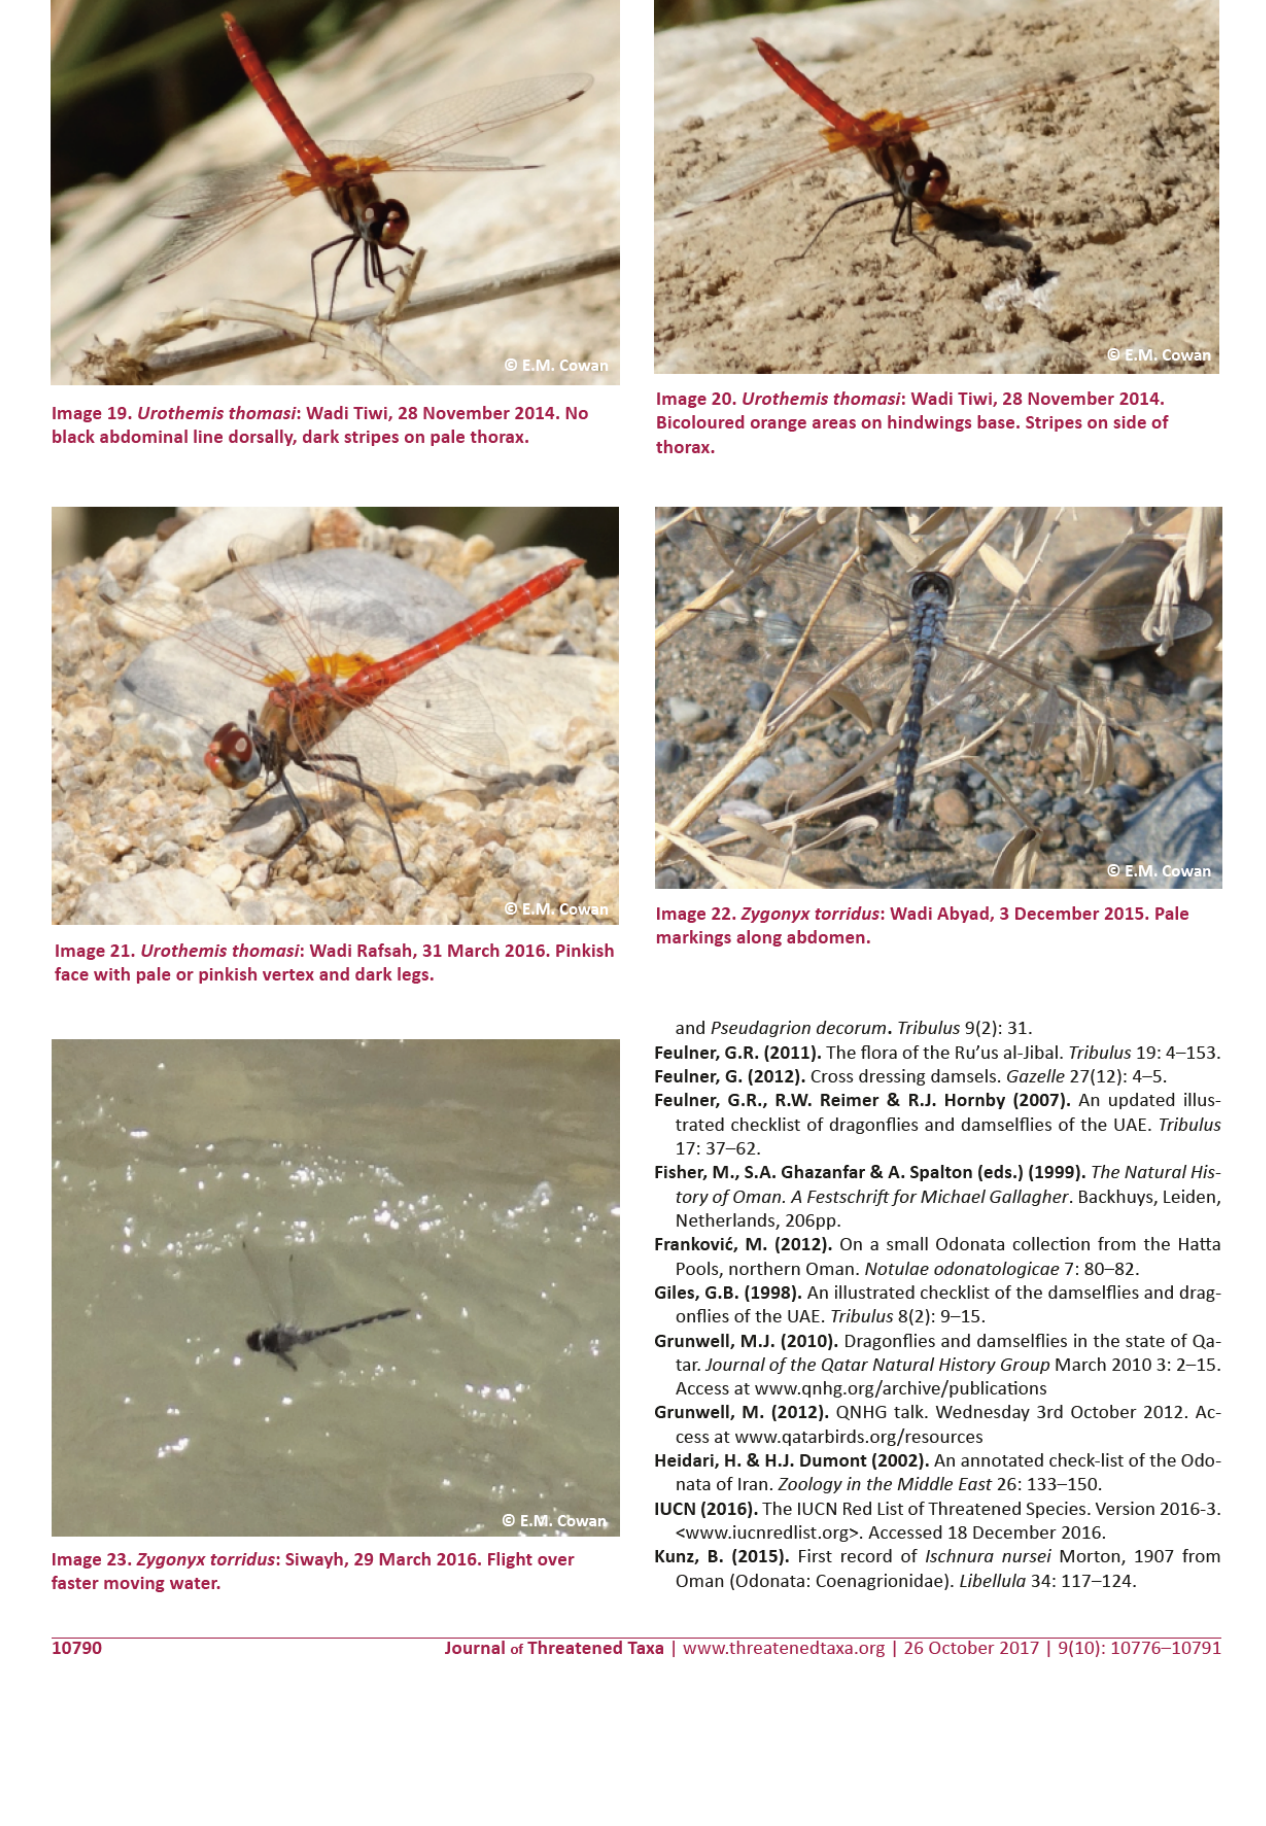
Image 20. Urofthemfis fthomasfi: Wadfi Tfiwfi, 28 November 2014. Bficofloured orange areas on hfindwfings base. Sftrfipes on sfide of fthorax.